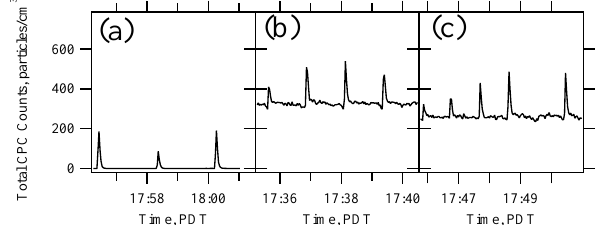
Fig. 4. Transmitted particle number density after the PCVI as a function of time for various supersaturations. During Period (a) the droplets remained below the cut-size and no particles were transmit- ted (supersaturation 0.25%). During Period (b) the ammonium sul- fate particles activated into droplets larger than the cut-size (0.5%). During Period (c) droplets grew to a size where impaction losses increased over those in Period (b) (0.75%; Kulkarni et al., 2011). See Fig. 3 for relevant droplet